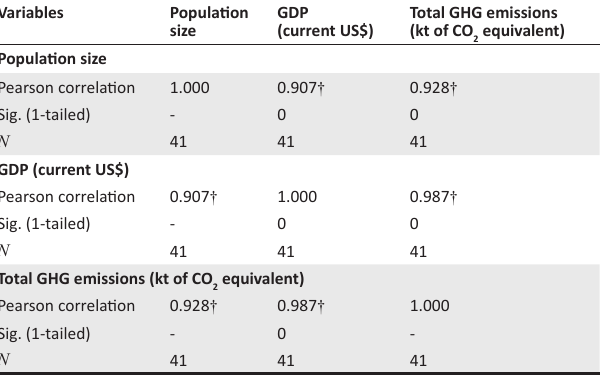
TABLE 2: Correlation analysis of among population size, carbon dioxide emissions size and gross domestic product (from 1972 to 2012). Variables Population size